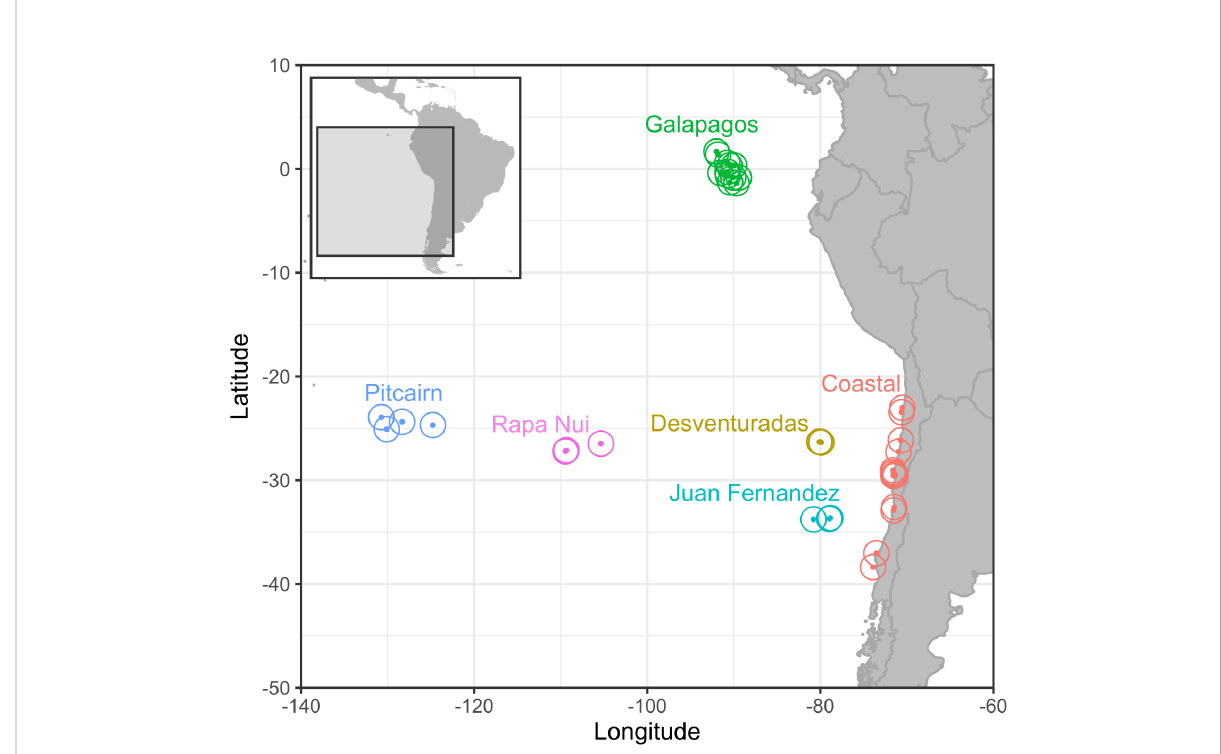
FIGURE 1 Location of the oceanic and coastal islands considered in the study. Islands are represented with a dot and a surrounding circle. The latter does not represent the 50 km buffer to obtain the oceanographic